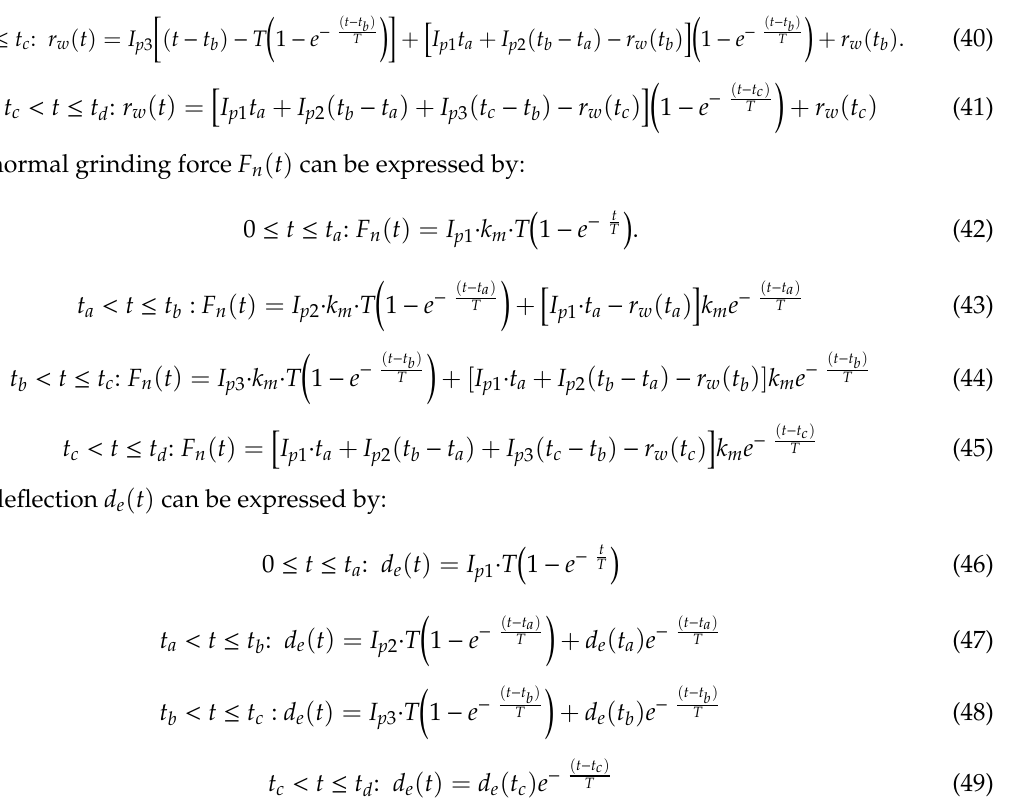
Figure 13. Diagram for infeed grinding cycle.